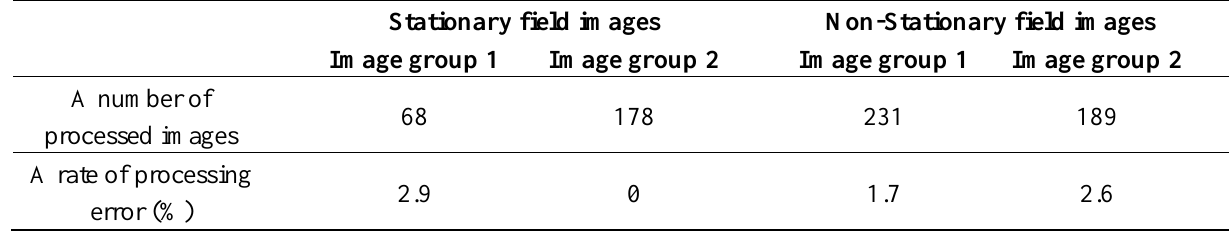
Table 1. Image processing error for individual plant